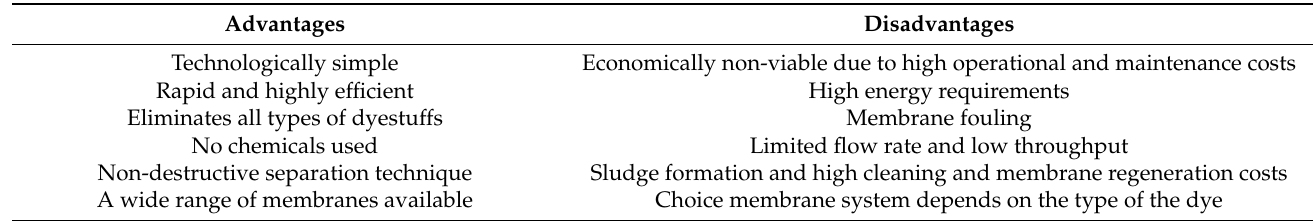
Table 7. The advantages and limitations of membrane filtration